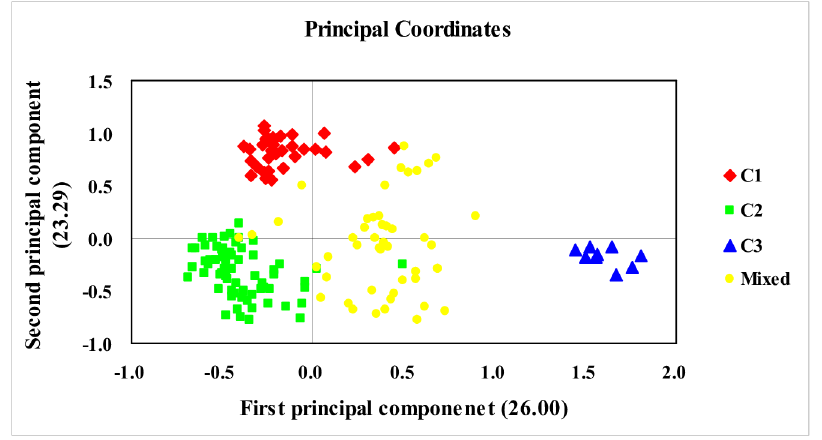
Fig 4. Scatter plot obtained from principal coordinate analysis of a genetic similarity matrix derived from 26 polymorphic sequence-related amplified polymorphism (SRAP) markersin 157 bermudagrass accessions.